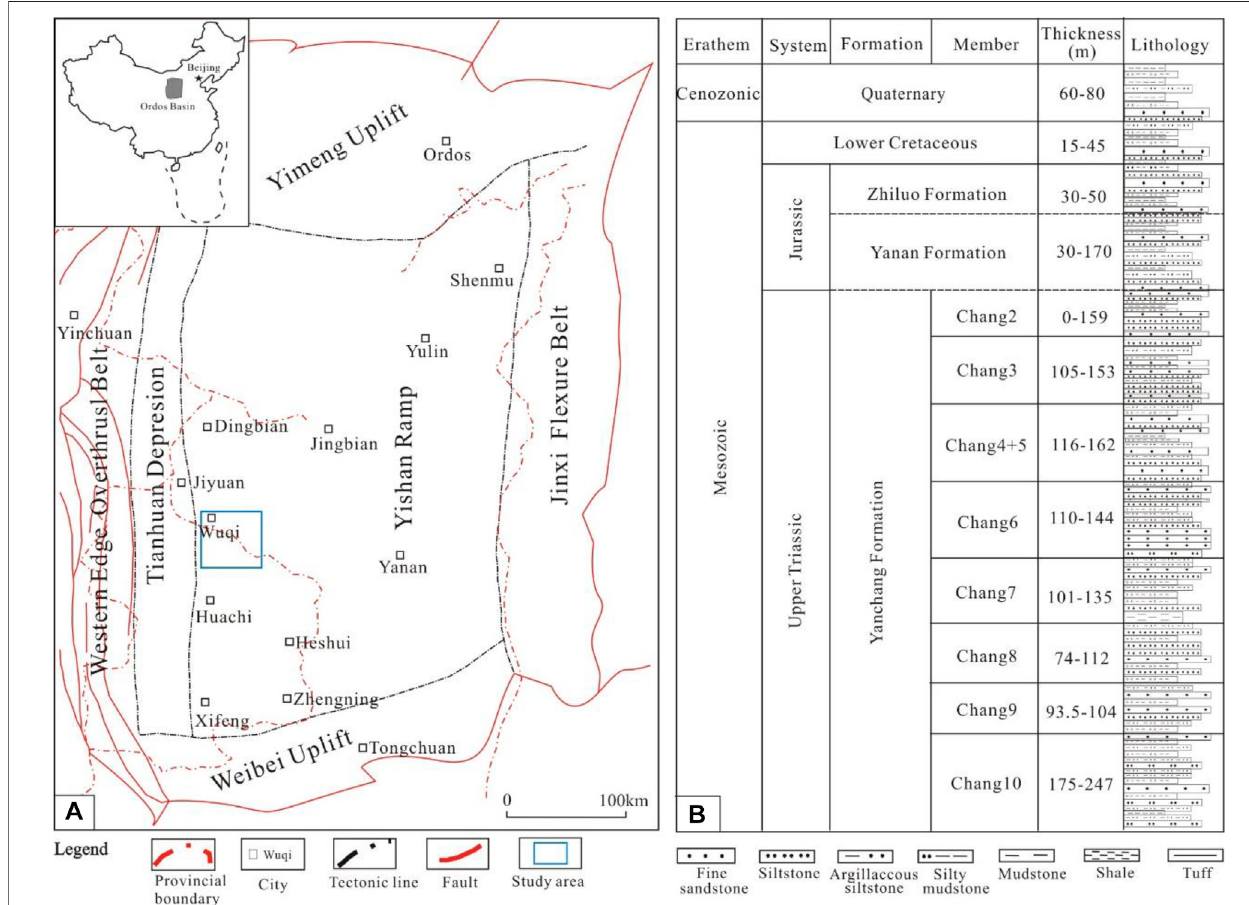
FIGURE 1 | Location of the study area and division of stratigraphic units of the Upper Triassic Yanchang Formation. (A) The study area is located in Block J in the west part of the Yishan Slope, Ordos Basin; (B) The target layer is the Chang 6 and Chang 8 Members of the Upper Triassic Yanchang Formation.